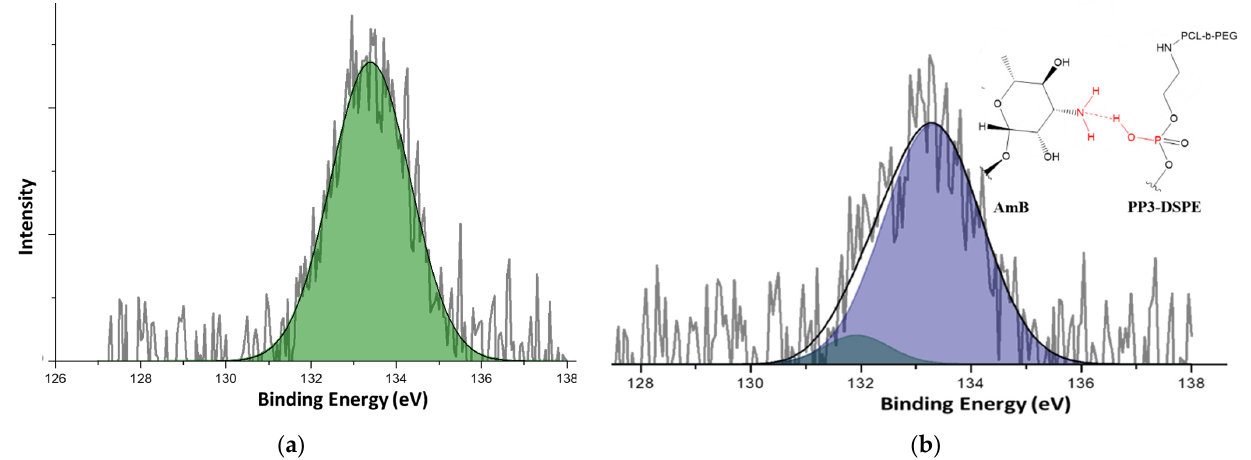
9 of 17 Table 2. Characterisation of micellar formulations. Drug content, hydrodynamic diameter (Dh) and ζ -potential values of empty and AmB-loaded nanoparticles measured at pH 7.0. Sample